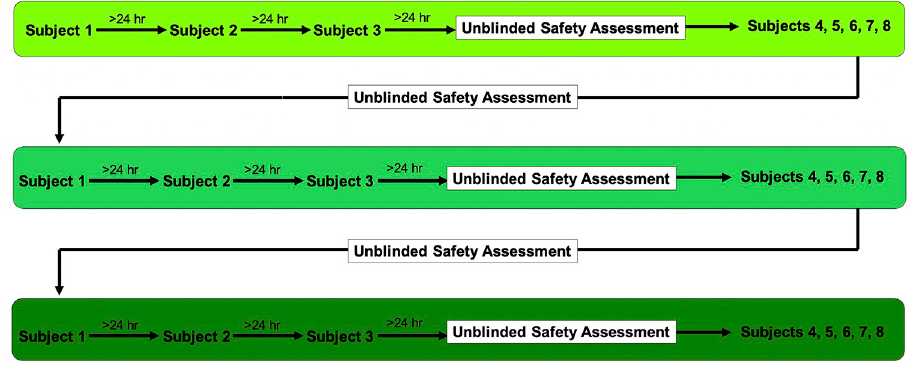
Fig 2. Schematic of the study